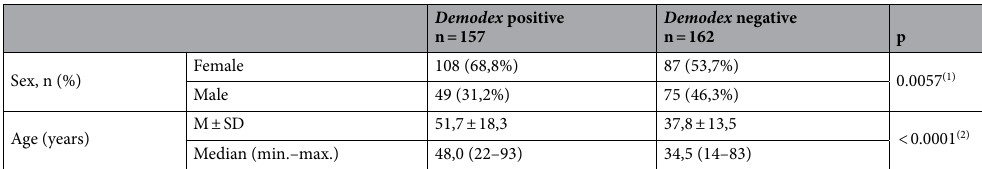
Table 1. Characteristics of the groups. Arithmetic mean (M), standard deviation (SD), p-value (p). (1 ) Pearson’s chi-square test result, (2) t-test result with Cochran–Cox